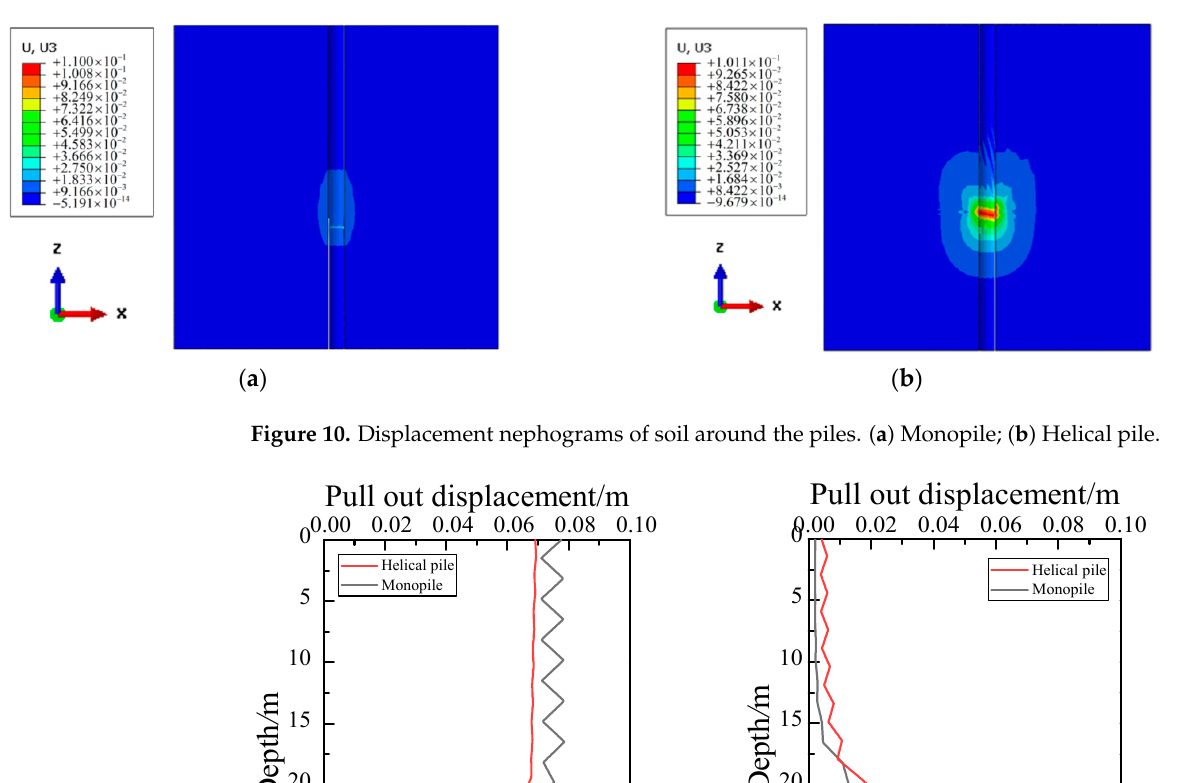
Figure 10. Displacement nephograms of soil around the piles. ( a ) Monopile; ( b ) Helical pile.